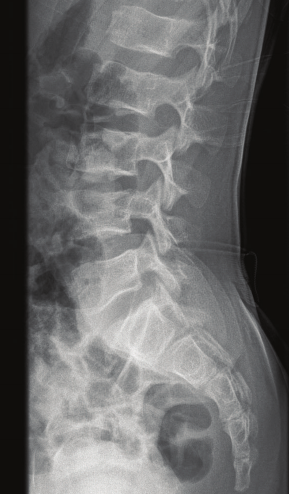
Figure 1: Lateral radiograph of the lumbar spine shows normal L3- L4 disk and normal endplates of L3 and